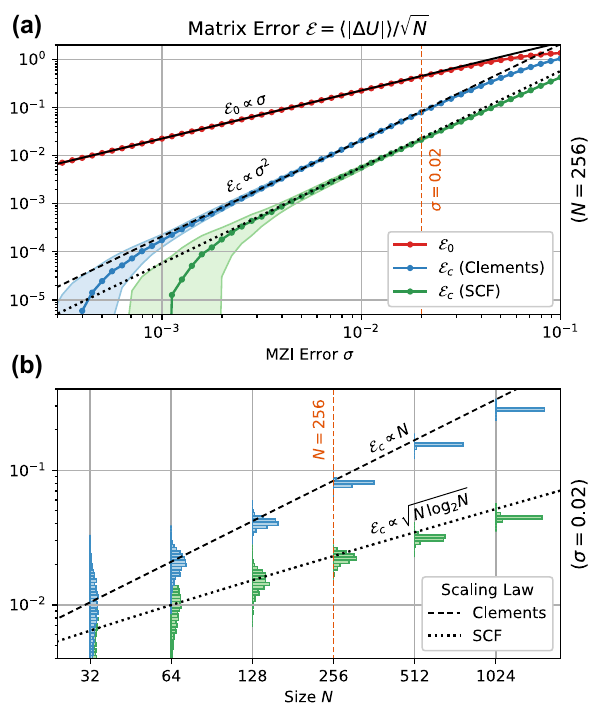
Figure 3: Comparision of matrix error scaling for the SCF and Clements meshes. (a) Scaling of matrix error with process variation 𝜎 . (b) Scaling of matrix error with mesh size, showing the advantage of the SCF mesh over the Clements mesh for larger mesh sizes.